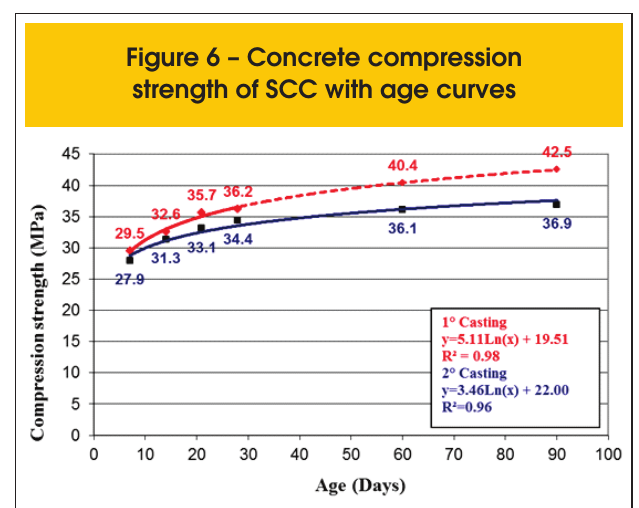
Figure 4 – Stress-deformations curves of 10 mm steel bars